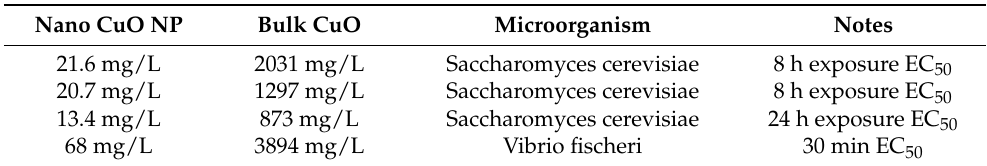
Table 7. Toxicity of nano and bulk CuO nanoparticles.